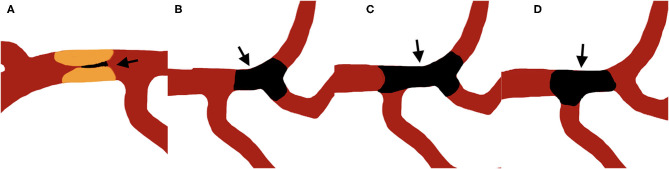
Illustration of jet-like appearance and non-jet-like appearance, arrows point to the thrombus. (A) shows a typical jet-like appearance of intracranial artery stenotic occlusion. (B–D) shows non-jet-like appearance of embolic occlusion with flat (B), convex (C), and concave (D) appearance at the proximal edge of the occluded vessel.